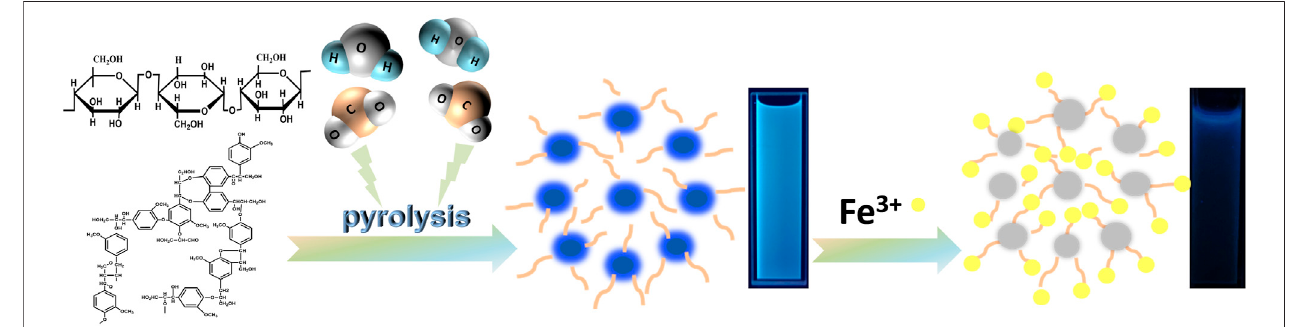
FIGURE 8 | Schematic diagram of the mechanism of cellulose and lignin-based CDs synthesised by solvent-free pyrolysis for the detection of Fe 3+ .